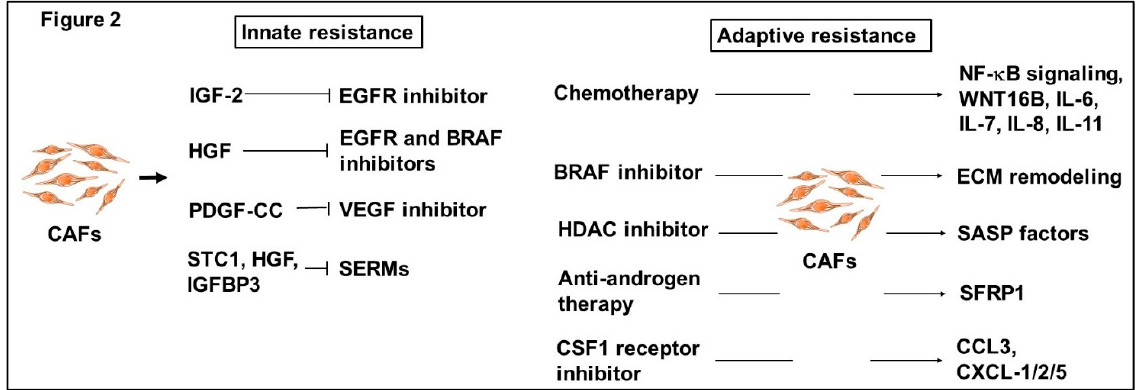
Figure 2. Emerging roles of CAFs for therapeutic resistance. CAFs play crucial roles in innate resistance to anti-cancer drugs (left). CAF-released insulin-like growth factor 2 (IGF2) provides cancer cells with tumor-initiating ability and EGFR-TKI-resistance. HGF produced by CAFs blunts the e ffi cacy of BRAF and EGFR inhibitors in BRAF-mutant melanoma cells and lung cancer cells via MAPK and PI3K / AKT signal pathways. CAF-produced PDGF-CC attenuates the e ffi cacy of anti-VEGF therapy via increasing neo-angiogenesis. Breast tumor cell-derived PDGF-CC also enables CAFs to produce stanniocalcin 1 (STC1), HGF and IGFBP3 that contribute to promoting conversion of luminal cancer cells into basal cancer cells, resulting in resistance to treatment with selective estrogen receptor modulators (SERMs). Upon therapeutic insult, CAFs acquire adaptive resistance (right). Chemotherapy induces pro-inflammatory phenotypes in CAFs via activation of NF- κ B signaling, resulting in enhanced production of Wnt family member wingless-type MMTV integration site family member 16B (WNT16B), IL-6 and IL-8 from these fibroblasts that provides breast cancer cells with chemoresistant ability. Increased levels of IL-7 and IL-11 production are also induced in CAFs by chemotherapy, rendering cancer cells tumor-initiating and apoptosis-resistant. Treatment of CAFs with the BRAF inhibitor induces ECM remodeling, resulting in activation of integrin β 1 / focal adhesion kinase (FAK) / Src and ERK signaling in melanoma cells. The histone deacetylase (HDAC) inhibitor treatment enables CAFs to produce the senescence-associated secretory phenotype (SASP) factors. Exposure to anti-androgen therapy encourages CAFs to produce SFRP1 that promotes prostate cancer neuroendocrine di ff erentiation. Treatment of di ff erent human carcinomas with the CSF1 receptor inhibitor targeting TAMs allows CAFs to boost CCL3 and CXCL-1 / 2 / 5 productions, resulting in the recruitment of MDSCs into tumors and thus promoting tumor growth and